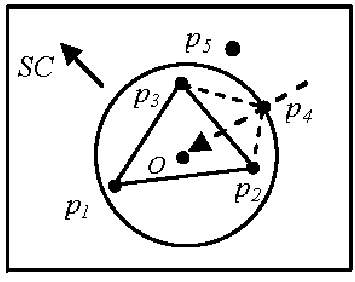
Figure 7. Adaptive dynamic threshold example.